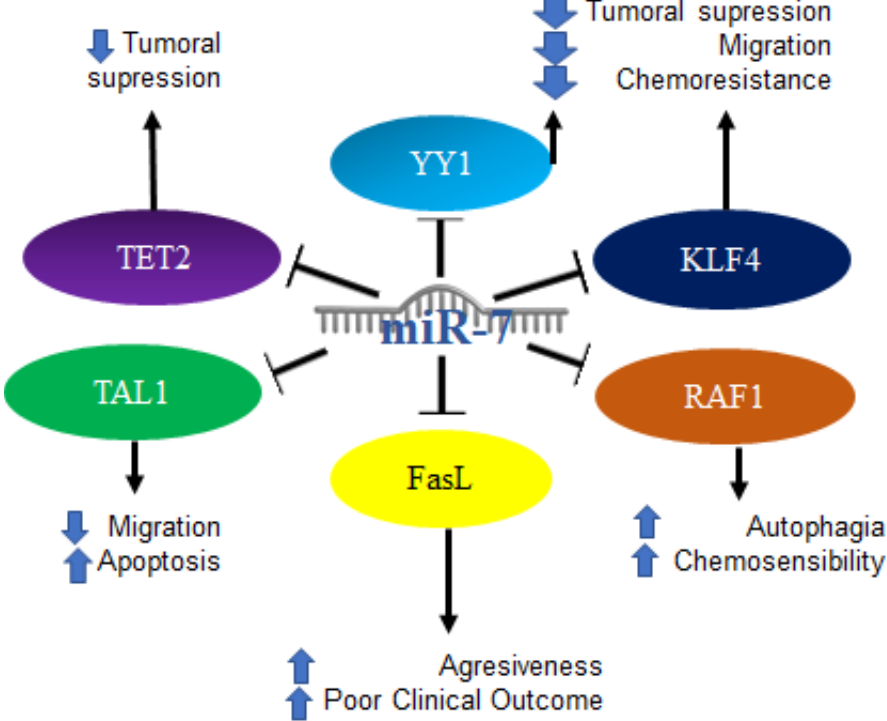
Figure 10. Role of miR-7 in hematological malignancies. Schematic representation of protein interactions with miR-7 and its biological consequences in the context of hematological malignancies.